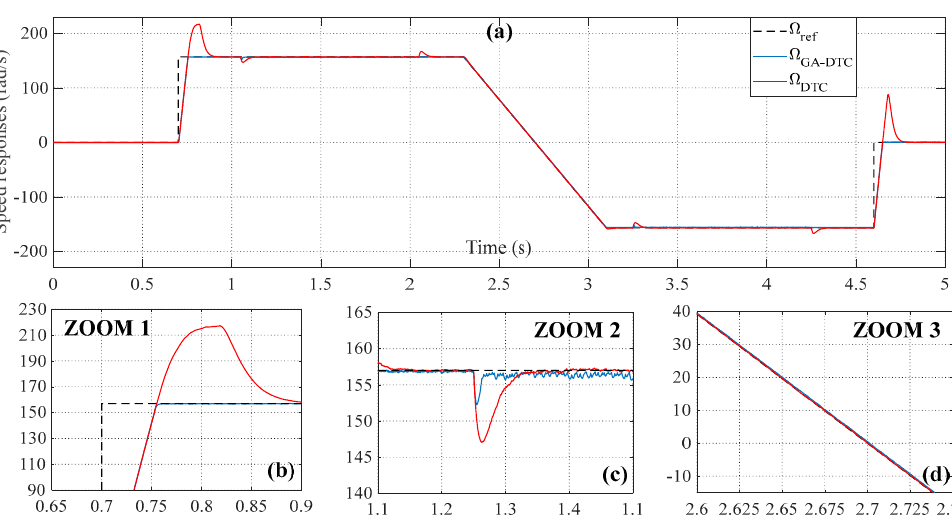
Figure 6. Speed responses ( a – d ) of both strategies.